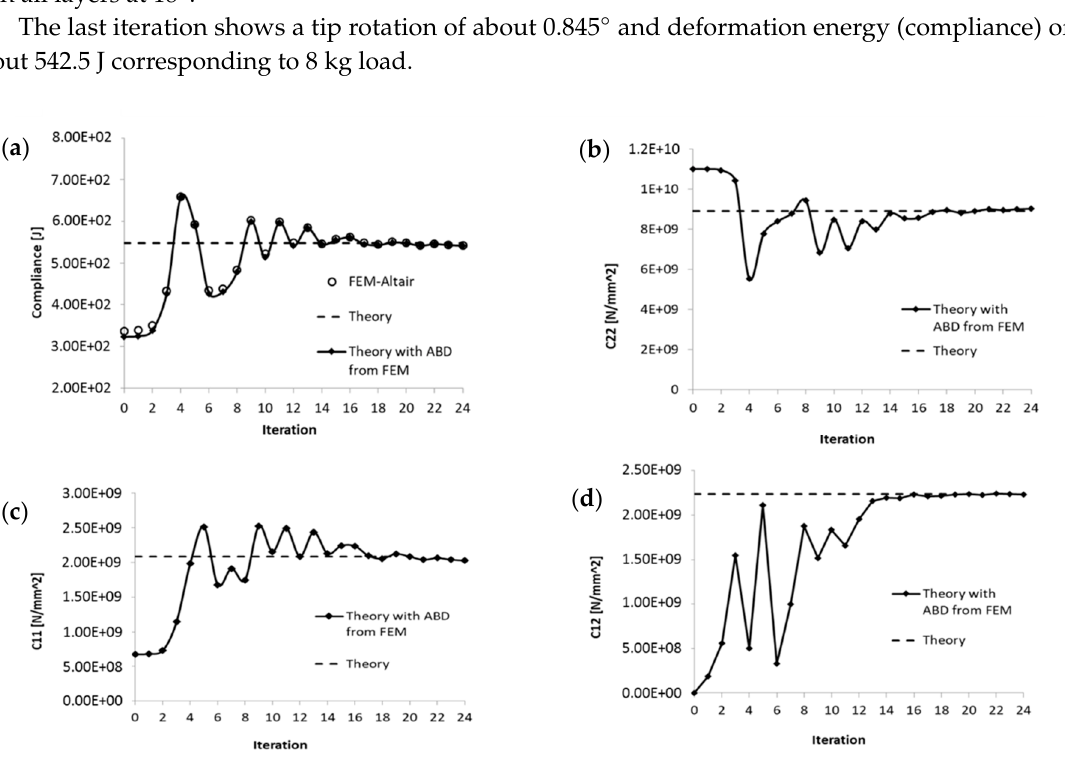
Figure 10. Gauge optimization graphs results: ( a ) Compliace; ( b ) Bending stiffness; ( c ) Torsional stiffness; ( d ) Coupling stiffeness. Table 2. Ply angles of best results by theoretical approach, gauge optimization (iterations 22th and 24th).